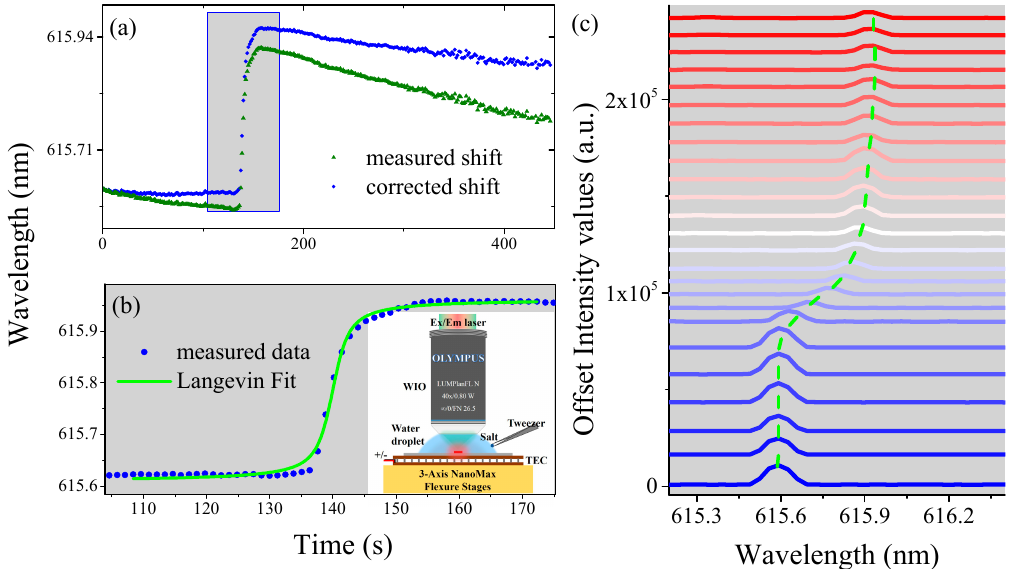
Figure 6. Monitoring the process of dissolution of salt in water using the lasing chemical sensor. ( a ) Measured lasing wavelength and corrected lasing wavelength shifts when adding the 14 mg salt in water under WIO. ( b ) Close-up view of corrected lasing wavelength and Langevin fitting. Inset shows the schematic diagram of operation process. ( c ) Dynamic change of lasing spectra in the process of dissolution of salt in water. The blue line (initial position) to red line (end position) is guided by the green dotted line.